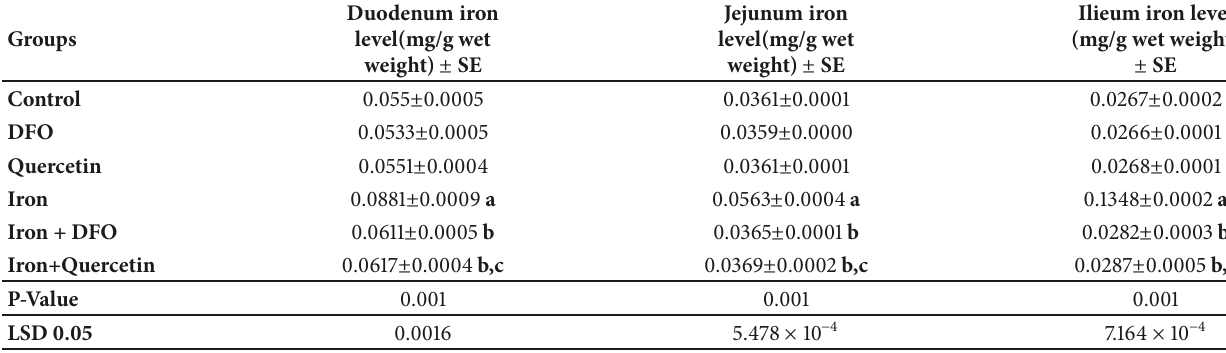
Table 2: Effects of Quercetin in comparison to DFO on small intestinal iron levels in iron overloaded rats.